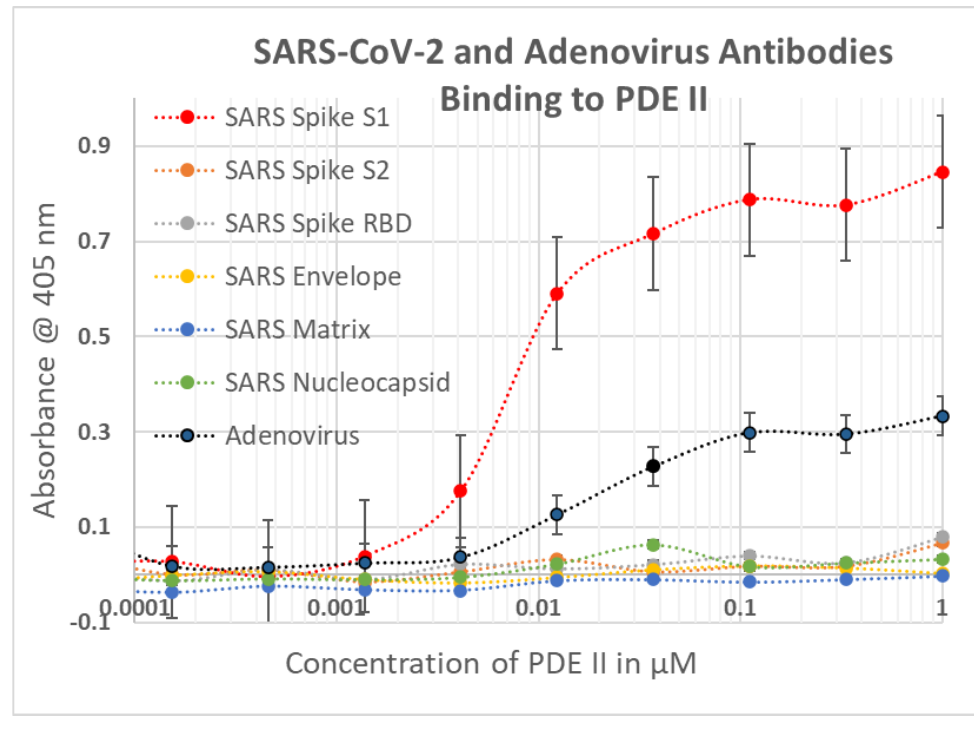
Figure 3 . ELISA results showing SARS-CoV-2 (SARS) and adenovirus polyclonal antibodies (rabbit) binding to phosphodiesterase II (PDE II). Experiments were run in duplicate.